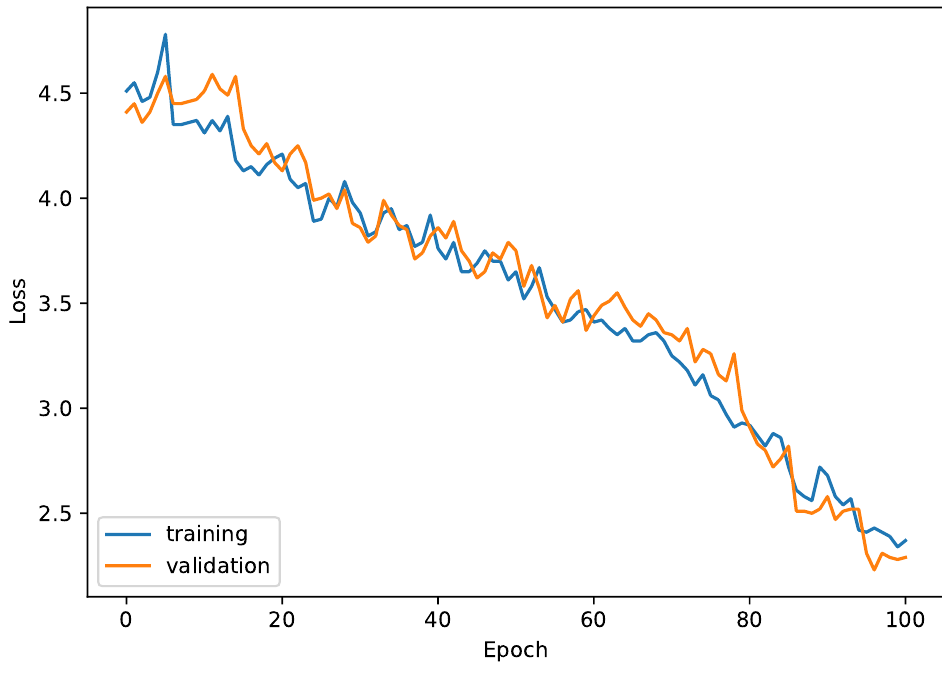
Figure 8. Mean square error (MSE) loss function for training and